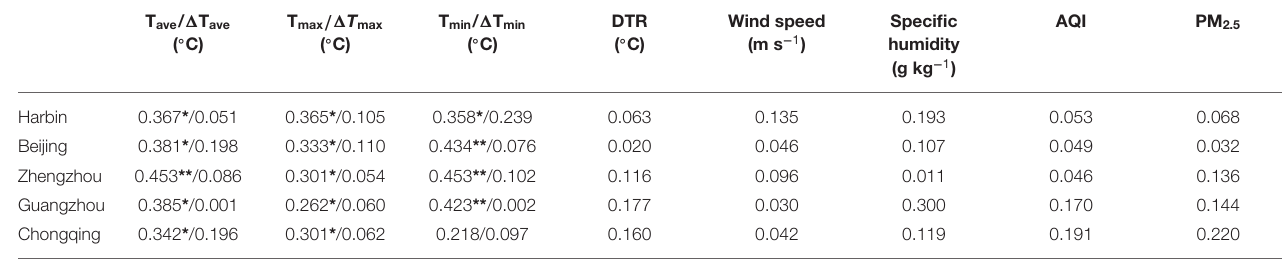
TABLE 2 | The Linear correlations between confirmed cases and meteorological and environmental factors.